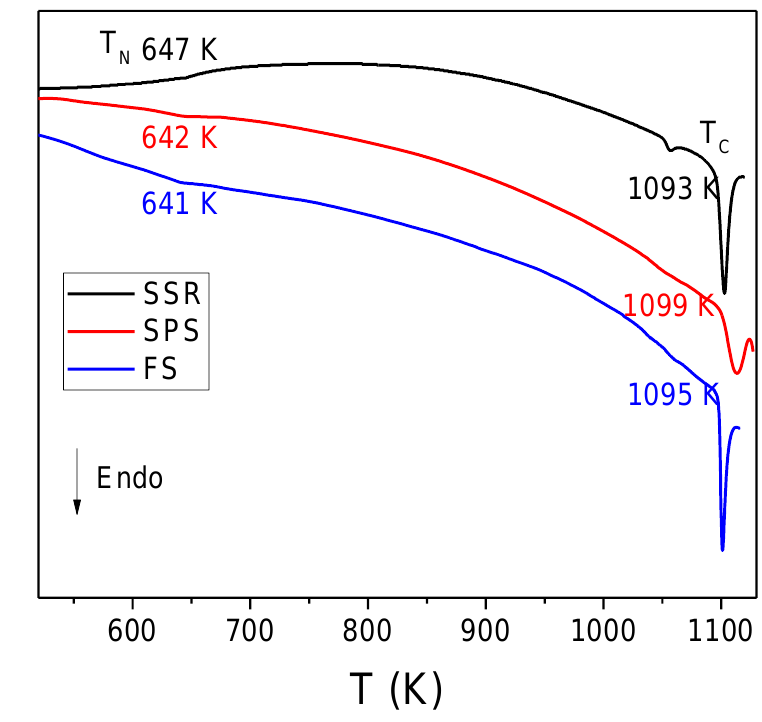
Figure 2. Differential scanning calorimetry (DSC) curves of BiFeO 3 prepared by SSR and by mechanosynthesis and subsequently densified by SPS or FS.